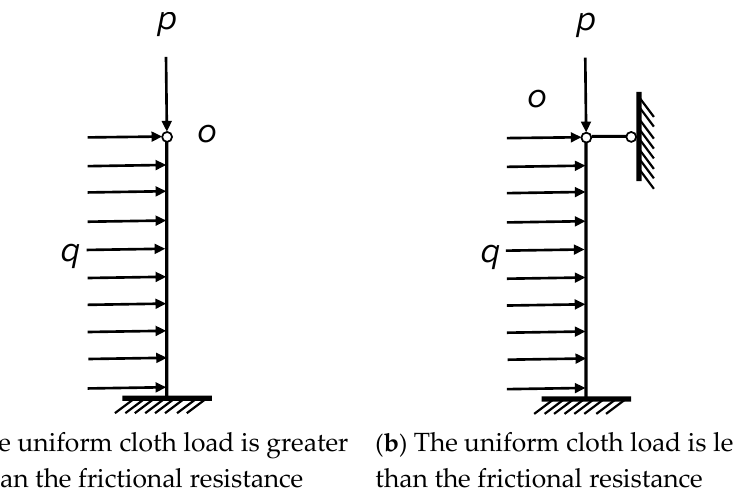
q P -top plate pressure, -the set of horizontal loads,